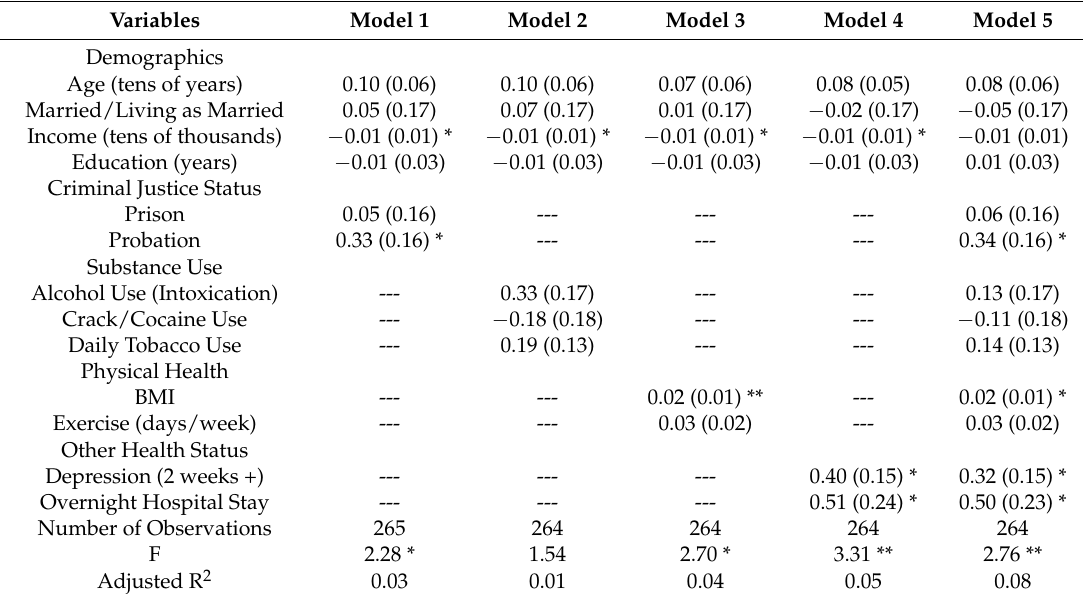
Table 4. Regression predicting health matters network mean discussion frequency at follow-up with baseline demographic and health status/behavior